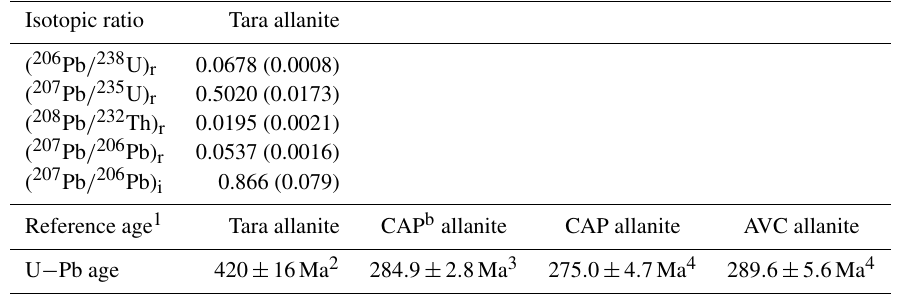
Table 2. Reference data of Tara allanite for normalization of U − Th − Pb isotopic data by LA-ICP-MS and published U − Pb Tera–Wasserburg ages of CAP b , CAP, and AVC allanite secondary reference materials. The ratios for Tara allanite are averages calculated from the measure- ments by Smye et al. (2014) by ID-TIMS; one measurement was excluded (see text). Uncertainties are given in brackets and are calculated as 2 standard errors. The subscript r indicates the radiogenic ratio, and the subscript i indicates initial. Isotopic ratio Tara